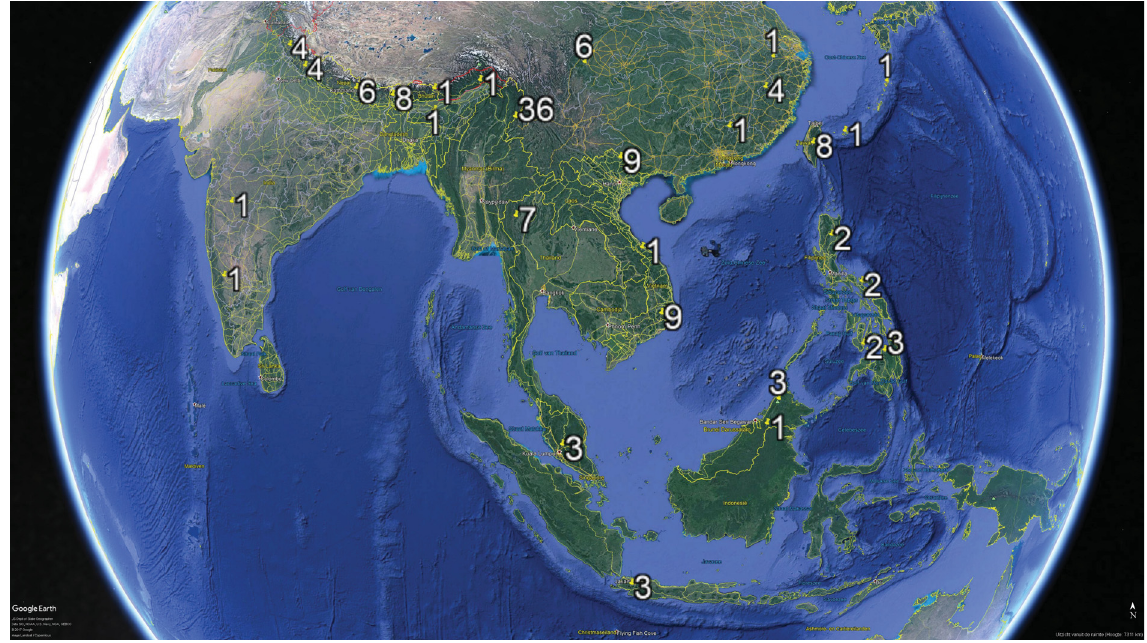
Fig. 99. Distribution of Sphegina in the Oriental region, with number of species for